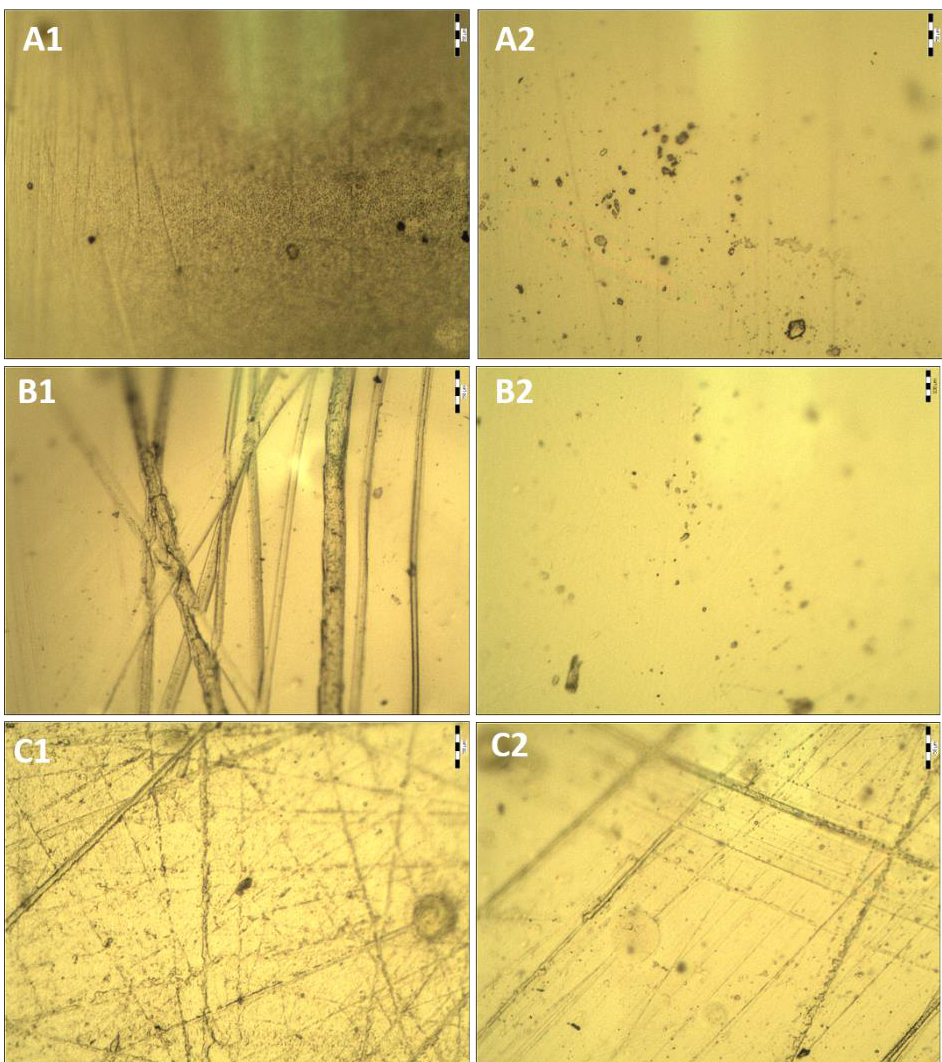
Figure 5. Optical images of HPMC – CS (2:1) unloaded film ( A1 ); different surface section of unloaded film ( A2 ); enzyme – loaded film ( B1 ); different section of enzyme-loaded film ( B2 ); enzyme-loaded film after 35 usage cycles ( C1 ); different surface section of enzyme-loaded film after 35 usage cycles( C2 ) . The scale bar represents 50 μm.